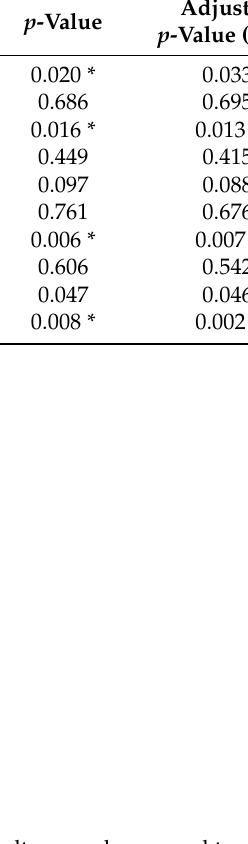
Figure 3. Cerebrovascular responsiveness to hypercapnia in the middle cerebral artery (MCA). Transcranial Doppler (TCD) ultrasound was used to measure blood flow velocity in the MCA in order to calculate treatment changes after 14 weeks in CVR to hypercapnia. a Significant difference between resveratrol and placebo ( p = 0.011; Cohen’s d = 0.69).